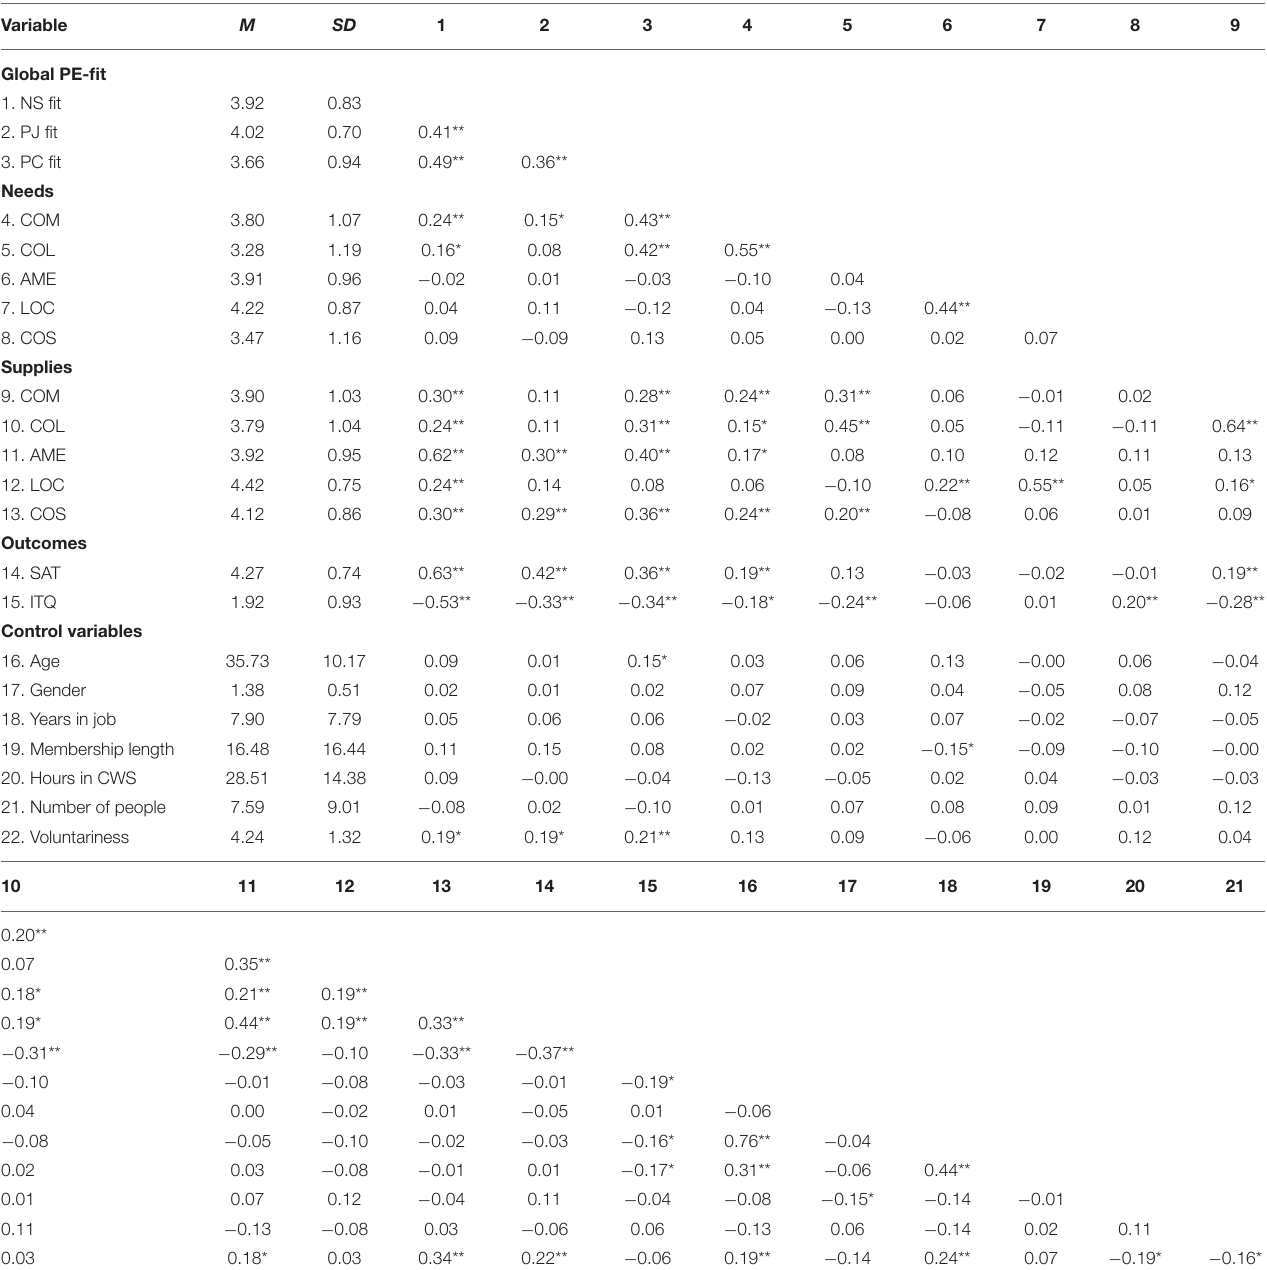
TABLE 1 | Descriptive statistics and